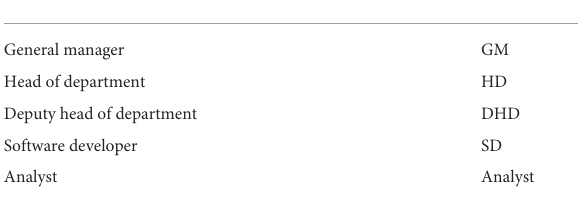
TABLE 6 Participant abbreviation description. Position Code